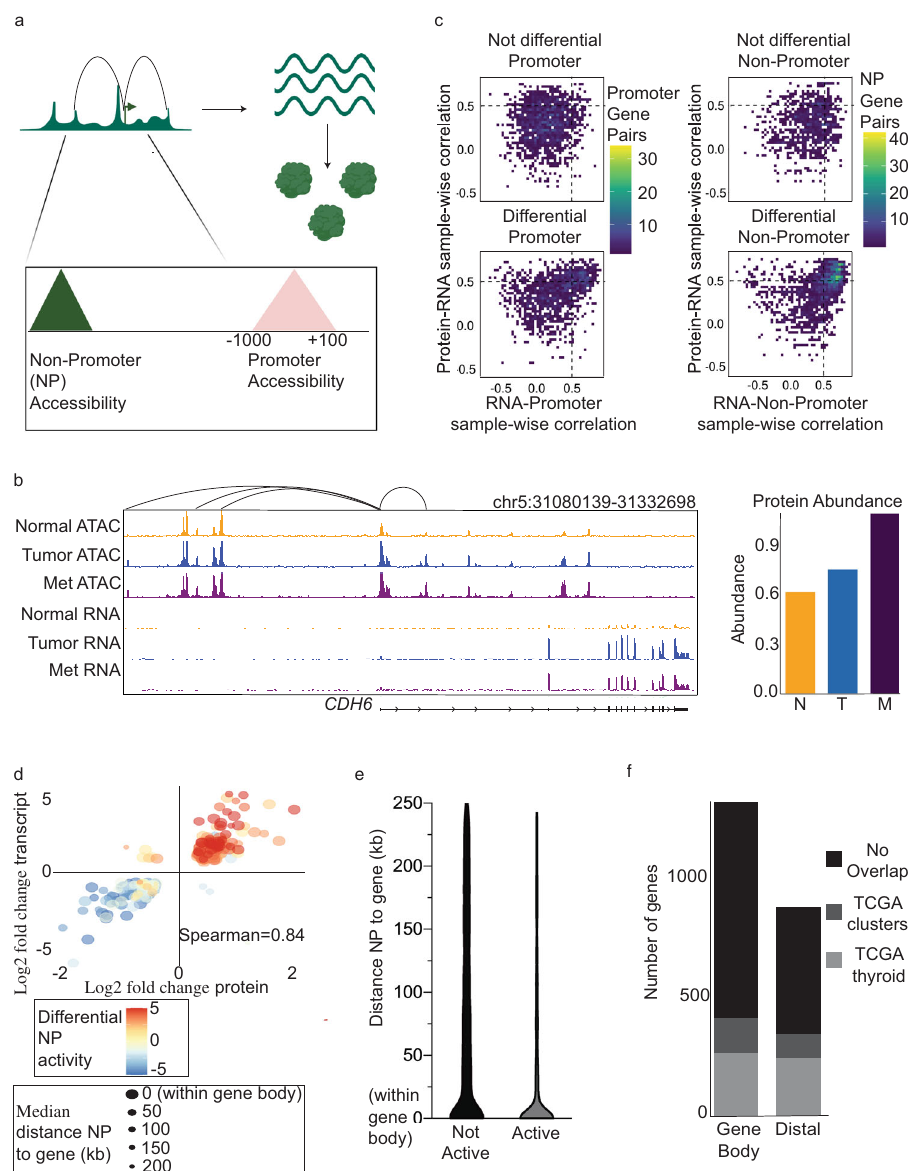
Fig. 2 Analysis of ATAC-seq peaks association with RNA and protein abundances. a Schematic of peaks linked to genes. b Visualization of peak – gene links for CDH6 and gene expression of CDH6 . Sample size; normal ATAC = 28, tumor ATAC = 30, met ATAC = 35, normal RNA = 27, tumor RNA = 30, met RNA = 30, normal protein = 21, tumor protein = 22, and met protein = 22. c Density of sample-wise correlation values, RNA – promoter and protein – RNA (left) and RNA – non-promoter and protein – RNA (right). The top graph includes only not differential regulatory elements (promoters on left and non-promoters on right) and the bottom graph includes only differential regulatory elements (promoters on left and non-promoters on right). d Gene- wise correlation for genes with differential non-promoter activity. e Distance between non-promoters to genes for active genes vs genes with no differential activity. f Overlap between TCGA ATAC-seq clusters and differential non-promoters within gene body (left) and distal to gene targets metastatic thyroid cancer cohort. Figure 2c shows the distribution of sample-wise correlations for promoter elements only (left graphs) and NP elements (right graphs). The y -axis of the graphs is the protein – RNA sample-wise correlation. The x -axis is the sample-wise correlation of chromatin accessibility of regulatory elements and RNA abundance of their gene targets. The regulatory elements that are graphed are linked to differentially expressed genes at either measure of expression (i.e., RNA and/or protein). The region of interest on the graphs is the upper-right quadrant as these gene- regulatory element pairs show high paired correlation values (de fi ned as correlation values >0.5, which represents an upper bound in the data). Differential promoter elements showed